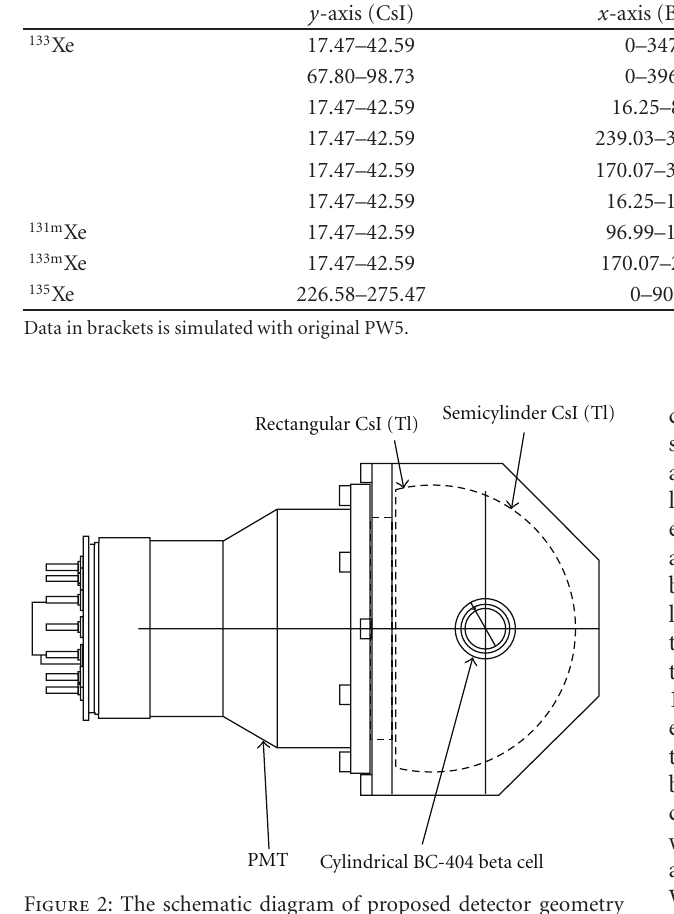
Figure 2: The schematic diagram of proposed detector geometry modeling by Geant4